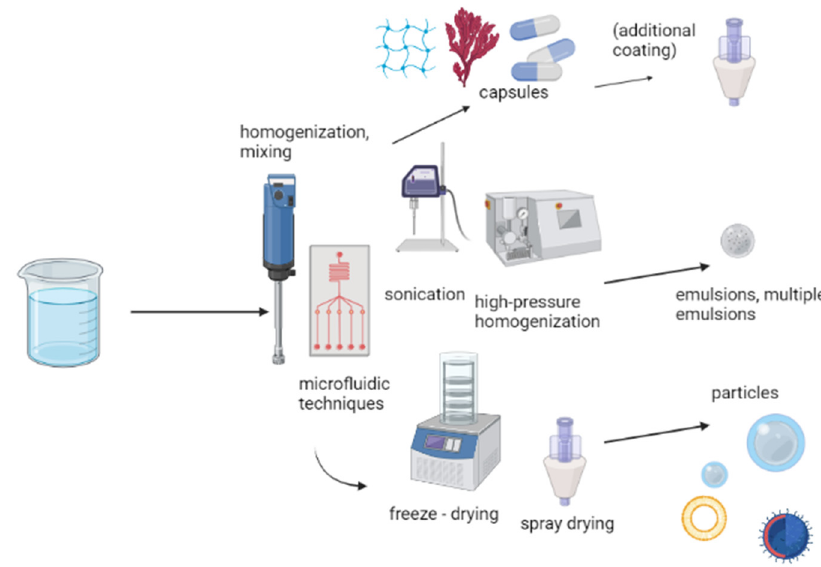
Figure 2. The most common approaches in encapsulation of agents.